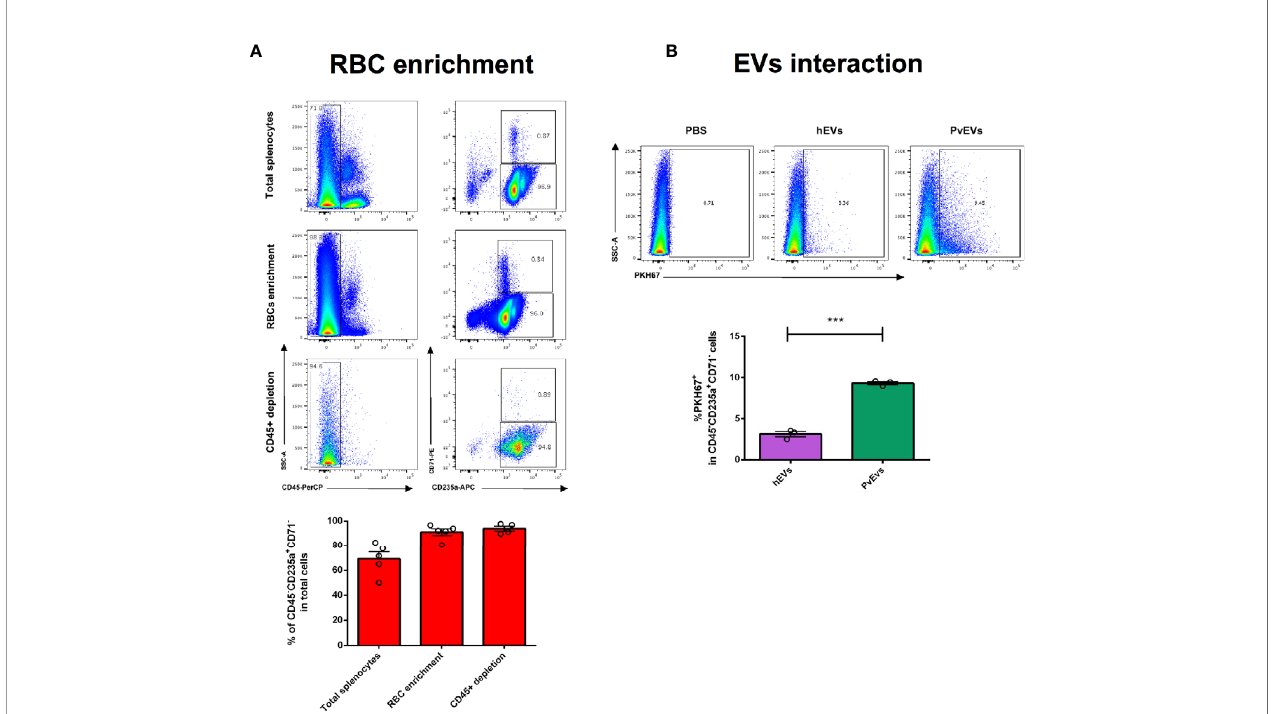
FIGURE 4 | Pv EVs and h EVs in vitro interaction with spleen mature red blood cells by fl ow cytometry analysis. (A) Red blood cells puri fi cation. RBCs were puri fi ed from spleen cell suspensions by a two-step procedure as shown in Figure 2 . Enriched RBCs were stained with fl uorescent conjugated antibodies against surface markers and analyzed by fl ow cytometry. Representative images show plots of the RBCs puri fi cation procedure. Data shown correspond to the mean and standard deviation of independent puri fi cations from fi ve spleen donors. (B) Pv EVs and h EVs in vitro interaction with spleen RBCs cells. Flow cytometry plots showing frequencies of mature RBCs positively stained with PKH67. PKH67 staining was gated according to cells incubated with PKH67-stained PBS. Frequencies quanti fi cation of three technical replicates is shown. Data is representative of two independent experiments performed with two spleen donors. Statistical signi fi cance (P<0.05) was assessed using a Student ’ s t -test, ***p <